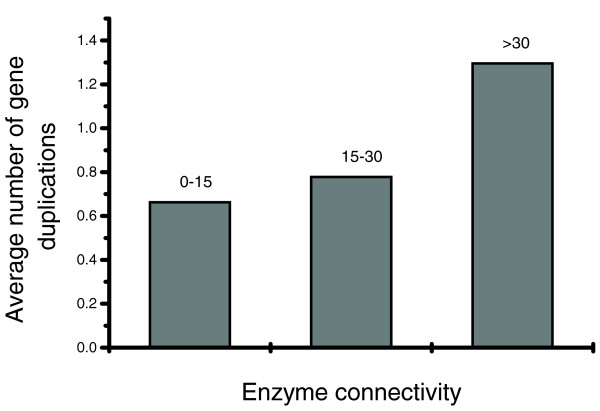
The relationship between enzyme connectivity and the average number of duplications in corresponding enzyme-coding genes. Enzymes with sequence identity larger than 40% over 100 or more aligned amino acids were considered as duplicates.